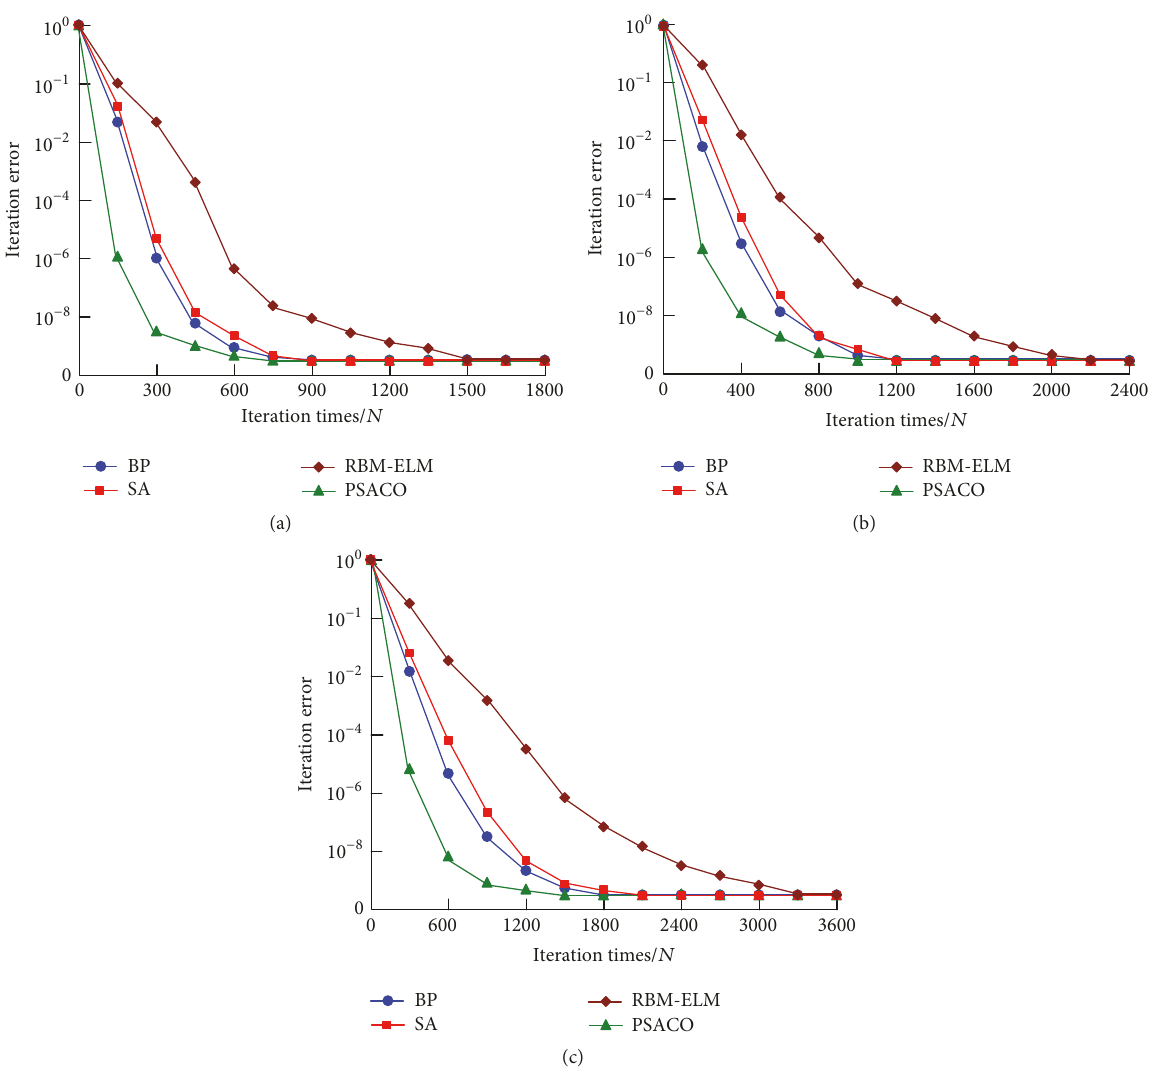
Figure 6: Clustering comparative results with the BP, SA, and RBM-ELM algorithms for CNIS-III: (a) original sample, convergence iteration times: 655, 748, 864, 1755; (b) damaged sample, convergence iteration times: 916, 1060, 1068, 2188; (c) transformed sample, convergence iteration times: 1217, 1631, 1640,